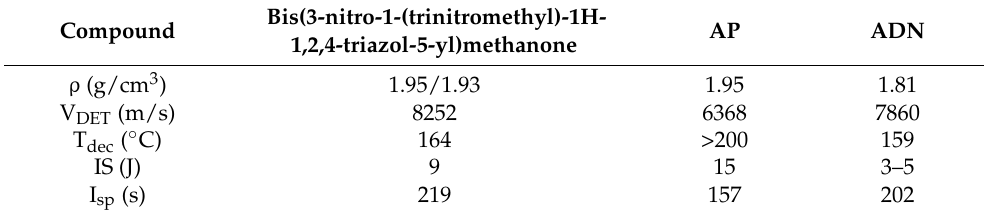
Table 4. Comparison of the properties of the described compound with AP and AND